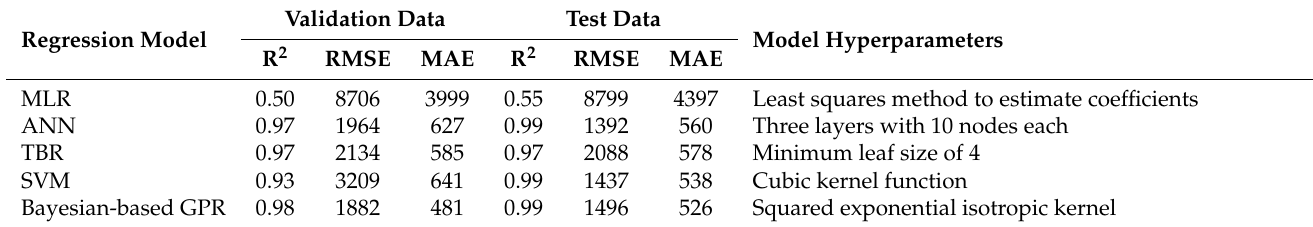
Table 4. Performance of prediction models across economic